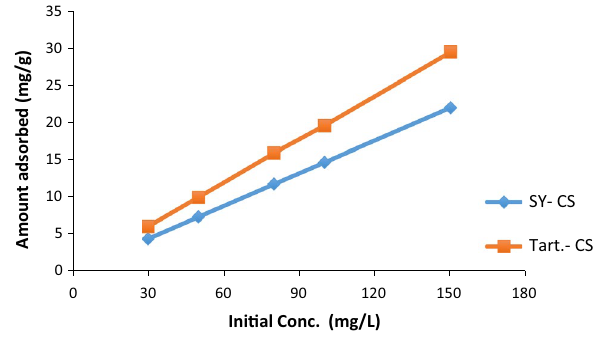
Fig. 4 Effect of initial dye concentration on the amount of dyes adsorbed onto CS